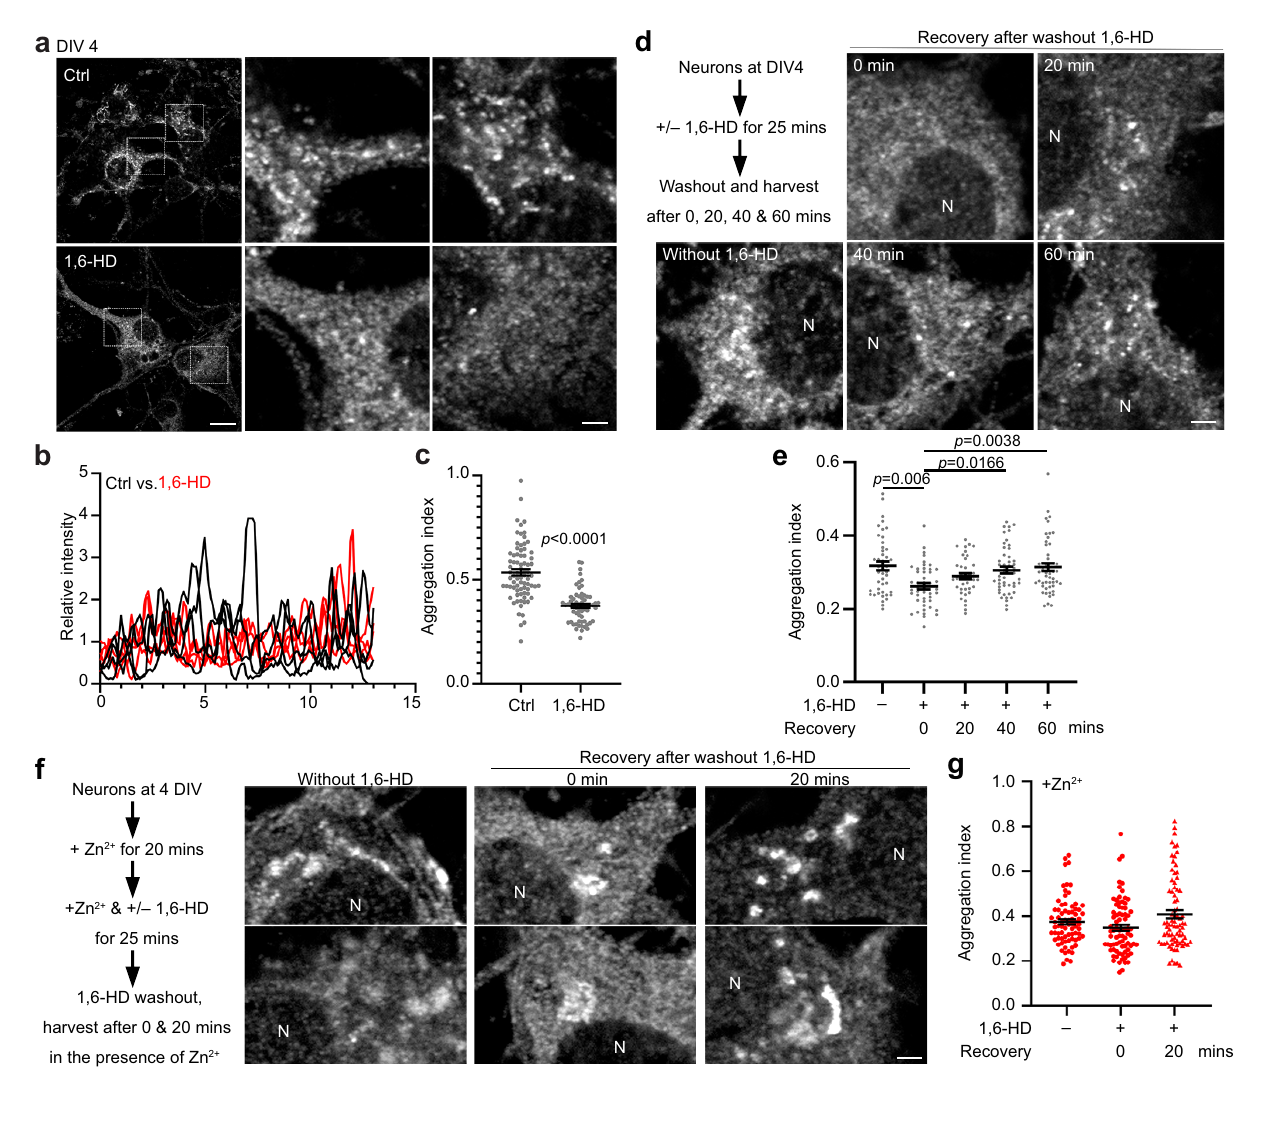
Fig. 6 CTTNBP2 forms condensates in immature neurons. a CTTNBP2 condensates in immature hippocampal neurons are sensitive to 1,6-HD treatment. At DIV 4, neurons were treated with 4% 1,6-HD for 25 min and then immunostained with anti-CTTNBP2 antibody. The insets in the low-magni fi cation images are enlarged in the middle and right panels. b Linescan quanti fi cation of CTTNBP2 immunoreactivity in somata. c Aggregation index (see the